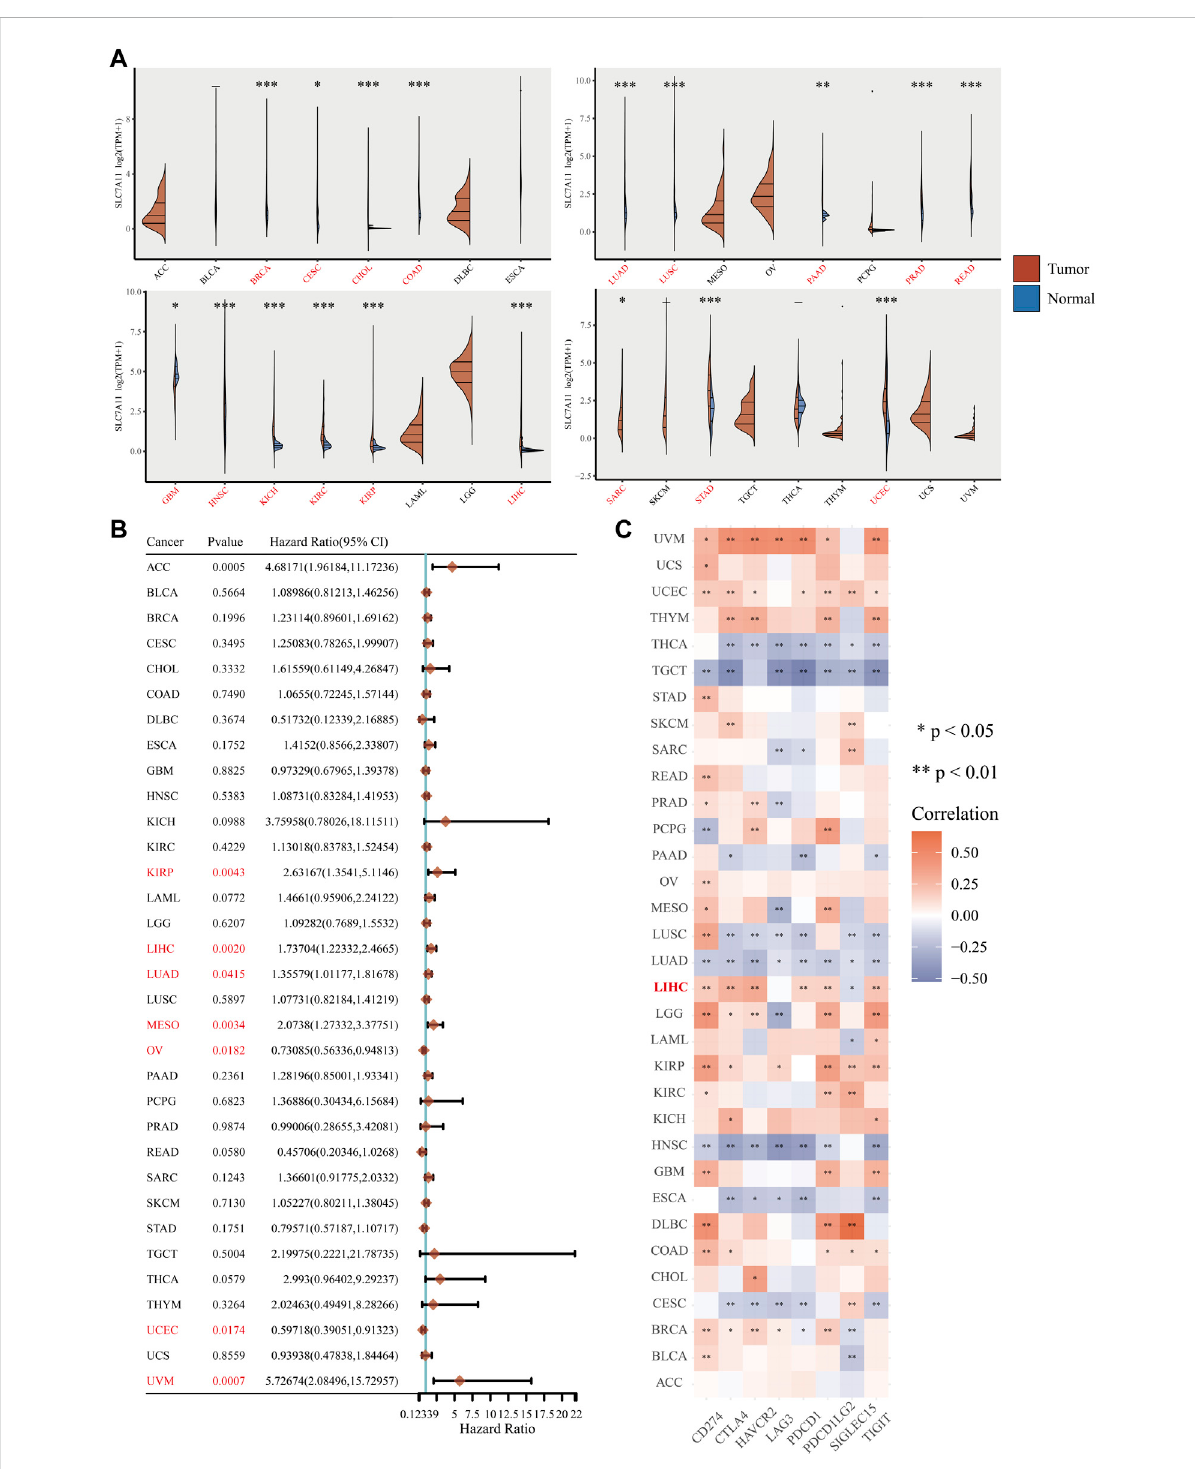
FIGURE 7 Association of SLC7A11 expression with prognoses and PD-L1 responses in multiple cancers. (A) Expression of SLC7A11 in normal and tumor tissues in 33 cancers. (B) The effect of high SLC7A11 expression on prognoses of various cancers. (C) Association of SLC7A11 with ICs in 33 cancer types. * p < 0.05, ** p < 0.01, and *** p <